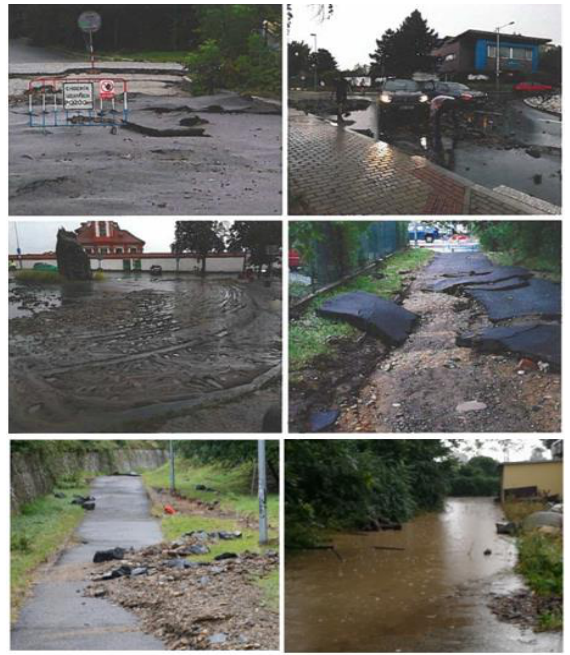
Figure 4 . Photo documentation of cloudburst damage